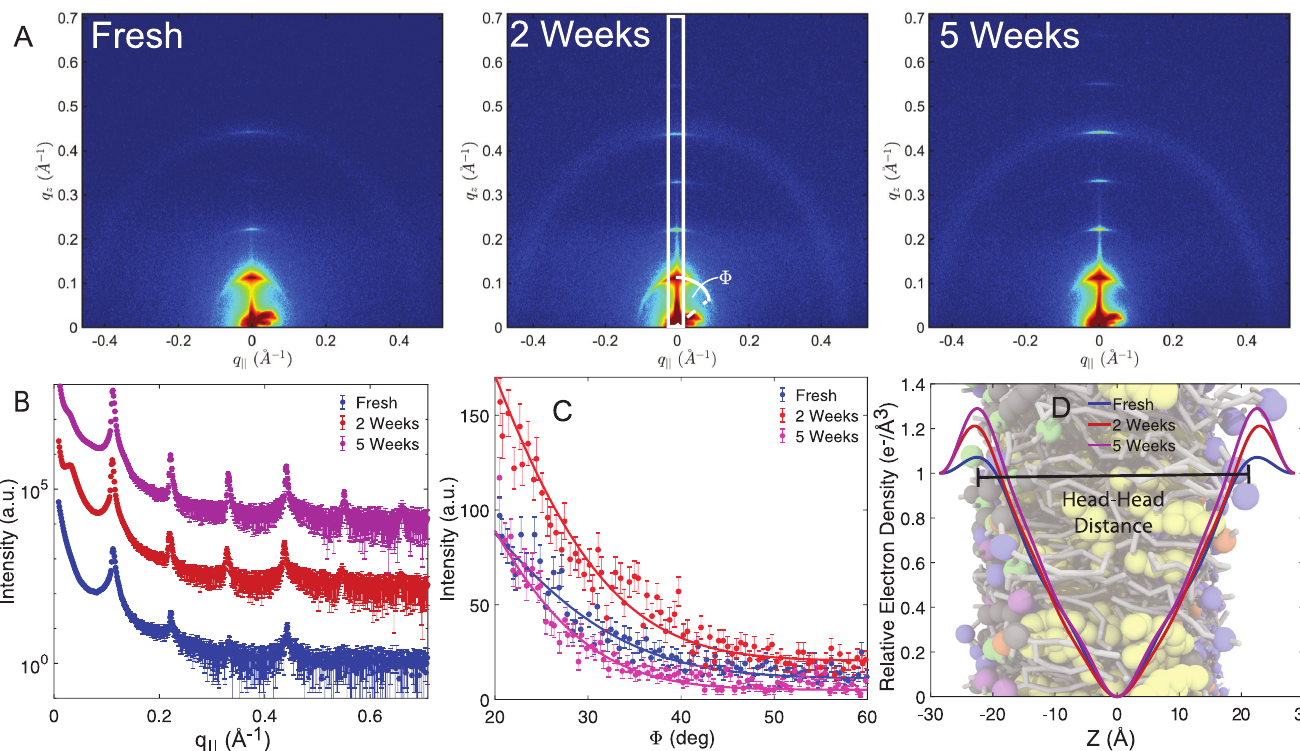
Fig 1. A Two-dimensional X-ray intensity maps measured at 88% RH for a fresh RBC cm sample and RBC collected from RC that was stored for 2 and 5 weeks respectively. Up to 6 orders of lamellar peaks were observed. B Specular reflectivity as determined from the integrated intensity marked as white rectangle. C X-ray intensity determined along the meridional angle F as indicated by the white line in A . The degree of orientation was determined by fitting Hermans orientation function. D Relative electron density profile determined from a 1-dimensional Fourier analysis. Maxima around | z | = 20 Å indicate the location of the electron-rich head-groups of the membranes while the electron density is reduced in the bilayer